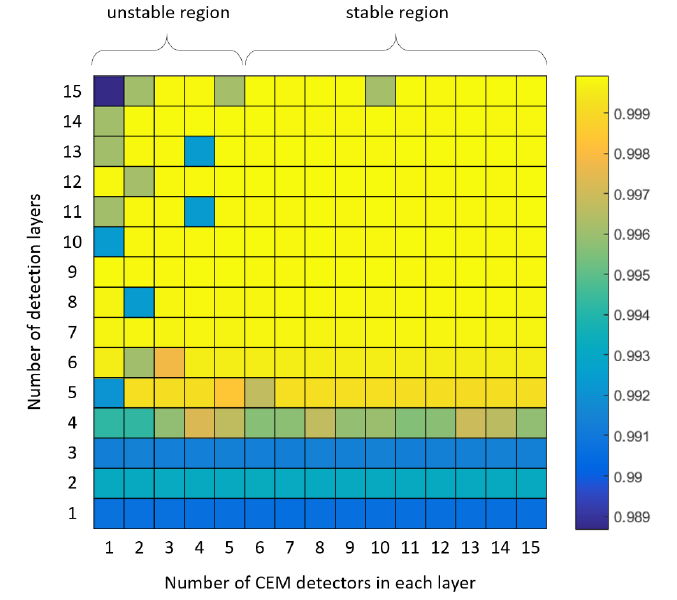
Figure 12. The area under the ROC of the proposed E-CEM detector’s detection results under its 1st ∼ 15th detection layers, and under the different number of base detectors in each layer (1 ∼ 15).